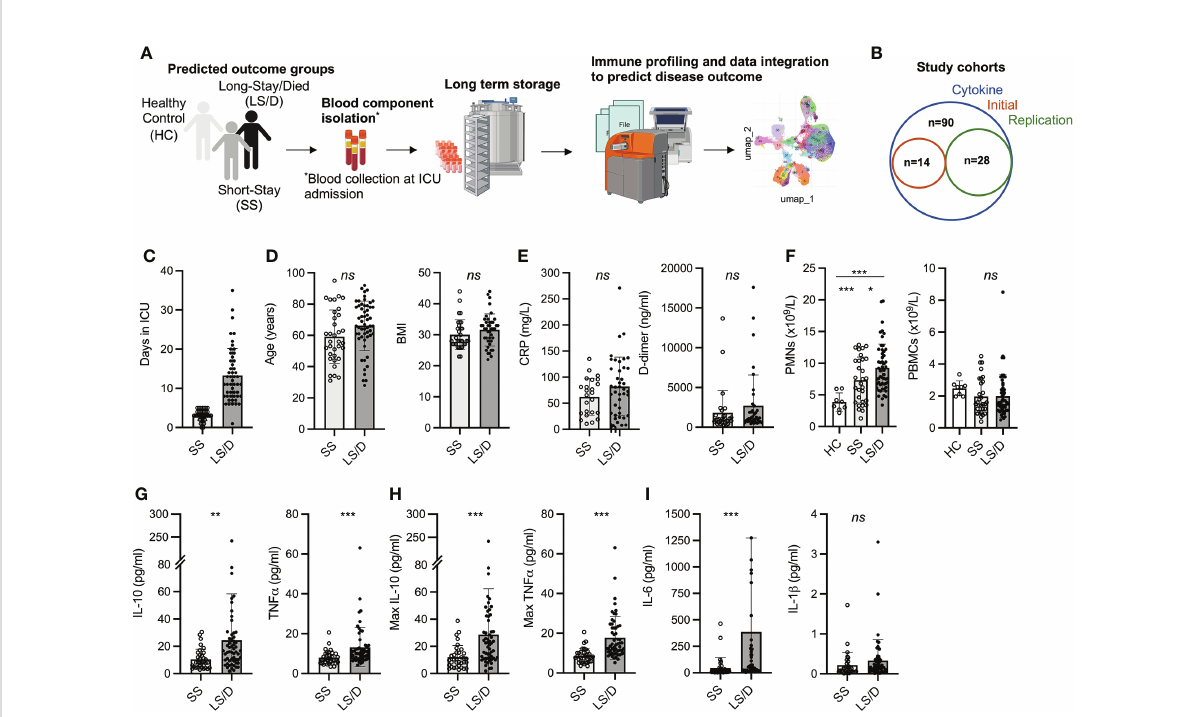
FIGURE 1 Patient cohort selection, characteristics, and cytokine analyses. Experimental design overview: peripheral blood was collected from COVID-19 patients within 48h of ICU admission; immune cells and serum were isolated and stored followed by immune cell subset and cytokine analyses and clinical data integration (A) . Patient cohorts overview; Initial Cohort SS patient n = 7, LS/D patient n = 7; Replication Cohort SS patient n = 12, LS/D patient n = 16 (B) . Patient outcome groups based on length of stay in ICU (C) . Patient age, body mass index (BMI), C-reactive protein (CRP) levels and D-dimer levels (D, E) . Complete blood counts of patients and healthy controls (F) . Serum cytokine levels of IL-10, TNF a , maximum IL-10, maximum TNF a , IL-6 and IL-1 b (G-I) . *p < 0.05; **p < 0.01; ***p < 0.001; ns p ≥ 0.05 by two-tailed, two-sample unequal variance Student ’ s